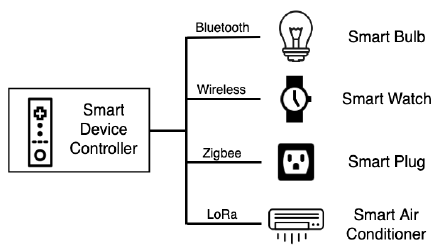
Figure 6. Wireless communication technology type of smart end device.